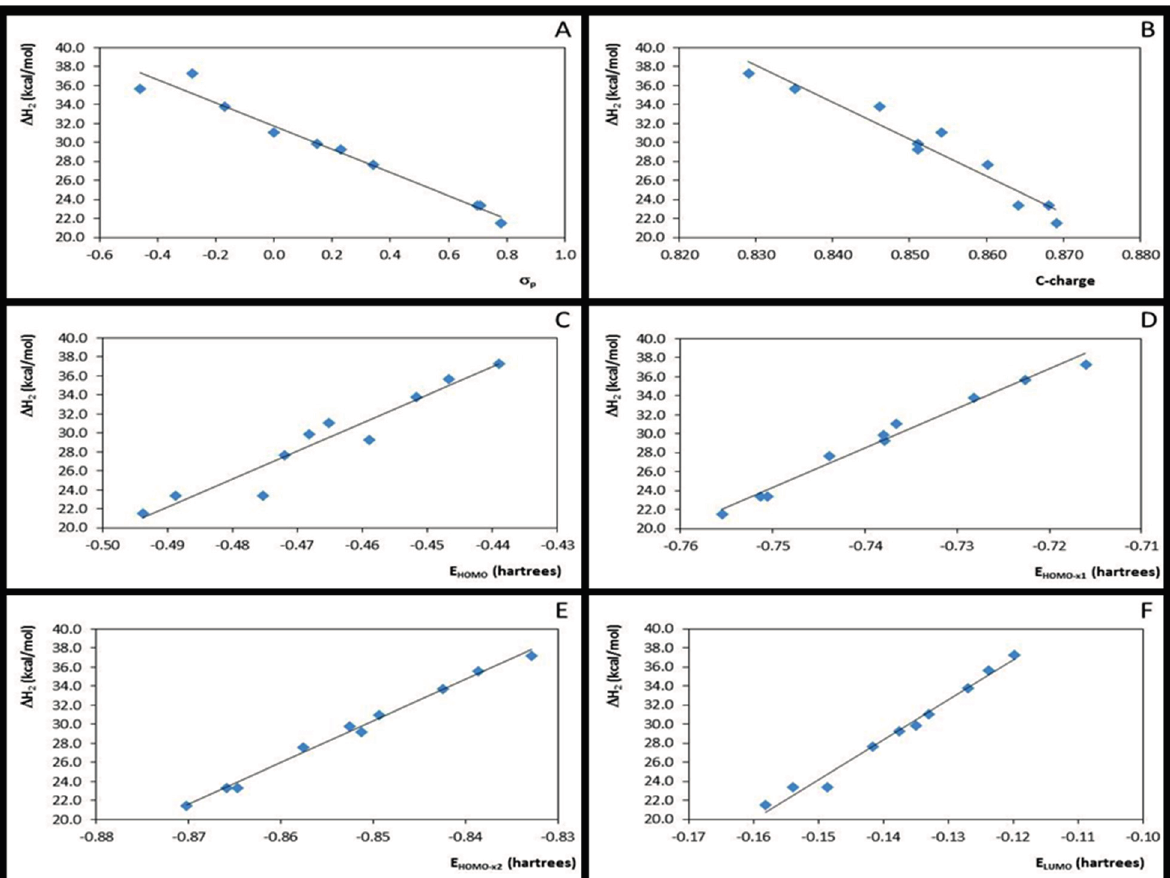
Figure 4. Plots for the correlation between enthalpies ( Δ H 2 ) values and Hammett substituent constant ( A ); C -charges ( B ); and HOMO, HOMO-x 1 , HOMO-x 2 and LUMO energies ( C – F ,